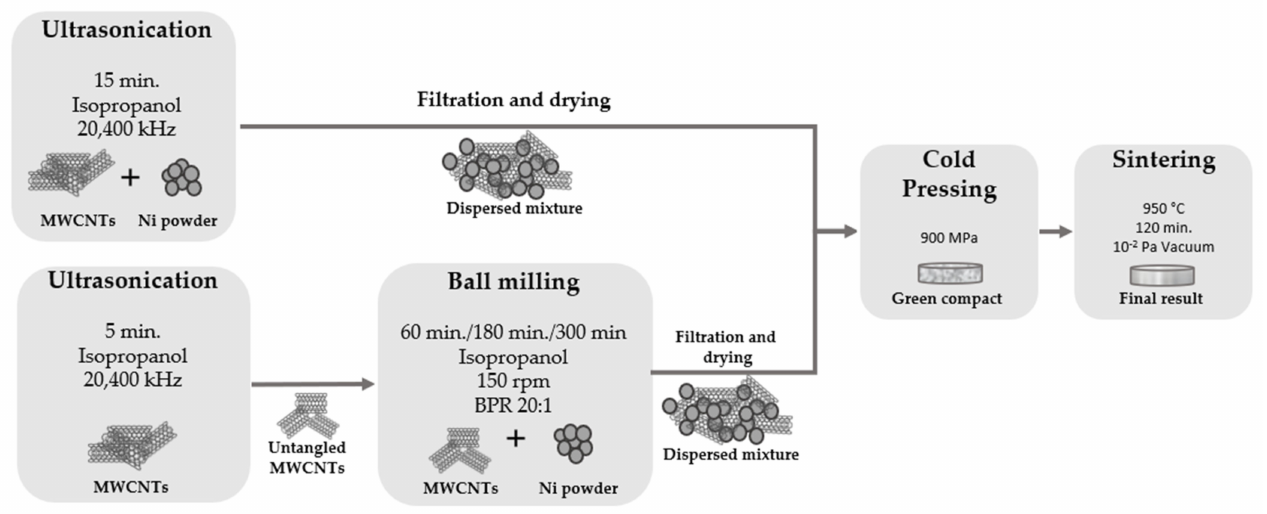
Figure 1. Schematic flowchart of the different routes used on the production of Ni-CNT